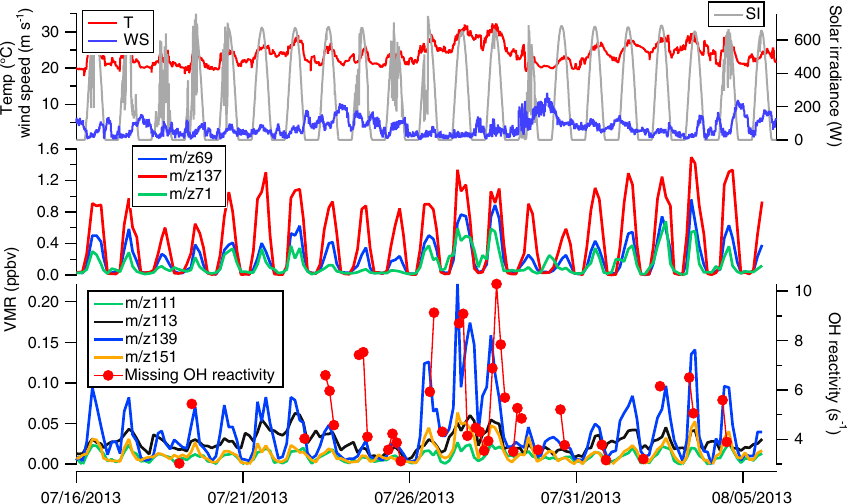
Figure 6. Volume mixing ratios (ppbv) of primary emitted and secondary produced biogenic volatile organic compounds (BVOCs) mea- sured by PTR-MS. Primary emitted BVOCs include isoprene ( m/z 69) and monoterpenes ( m/z 137) (middle panel); oxidation products in- clude methyl vinyl ketone, methacrolein, possibly isoprene hydroperoxides MVK + MACR + ISOPOOH ( m/z 71) (middle panel), nopinone ( m/z 139), and pinonaldehyde ( m/z 151, 111 and 113) (lowest panel). Top panel provides data of temperature, wind speed and solar irradiance. The lowest panel shows the variability of the missing OH reactivity, calculated as the difference between measured and calculated